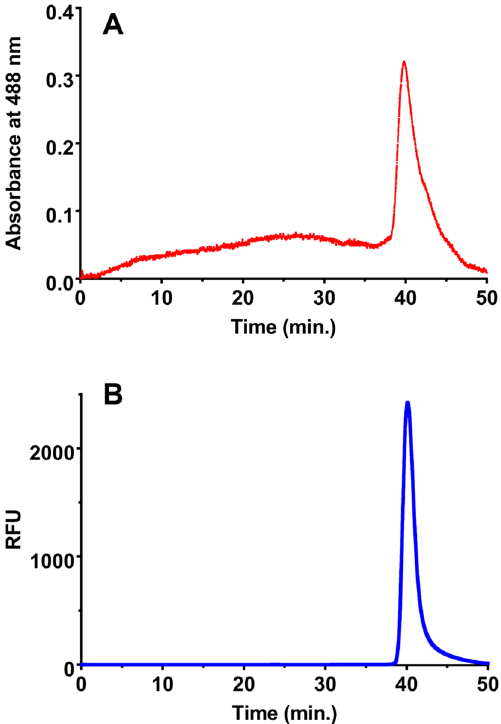
Figure 4. Size exclusion chromatography data of fCNC in aqueous mobile phase. ( A ) UV–Vis absorbance trace at 488 nm and ( B ) fluorescence (excitation at 495 nm and emission at 519 nm) trace of